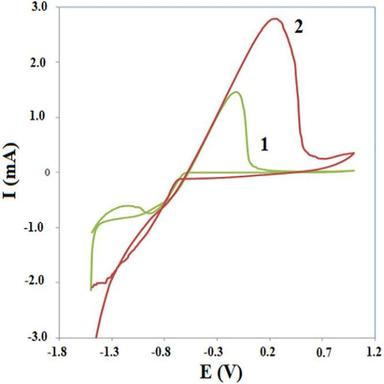
Cyclic voltammograms of CPE and GO-imi- (CH2)2-NH2/CPE 0.01 M Pb(II) in acetate buffer (pH 5.0).